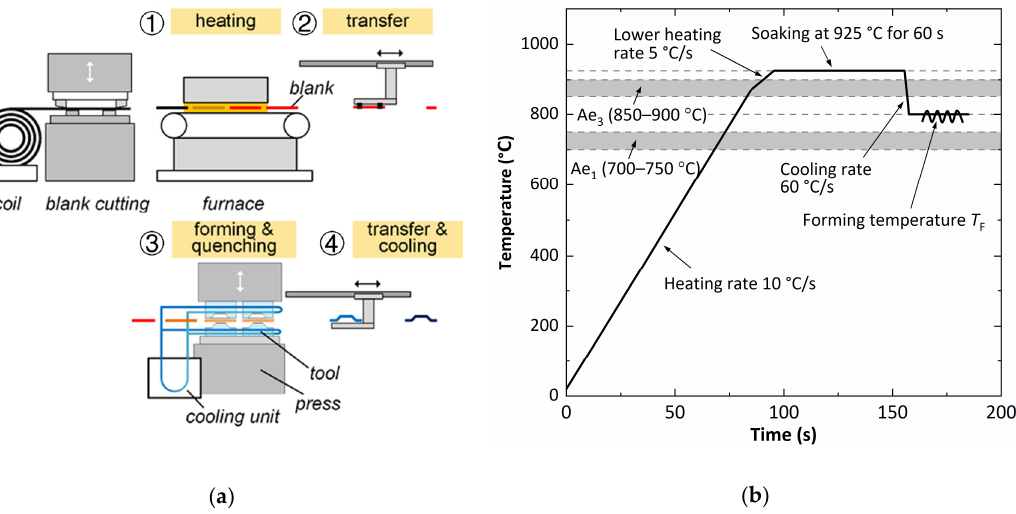
Figure 1. Schematic diagrams showing industrial hot-stamping: ( a ) a hot-stamping process including heating, transfer, forming and quenching, and transfer and cooling; ( b ) a thermal cycle to mimic the industrial hot-stamping conditions for boron steel 22MnB5 [7].